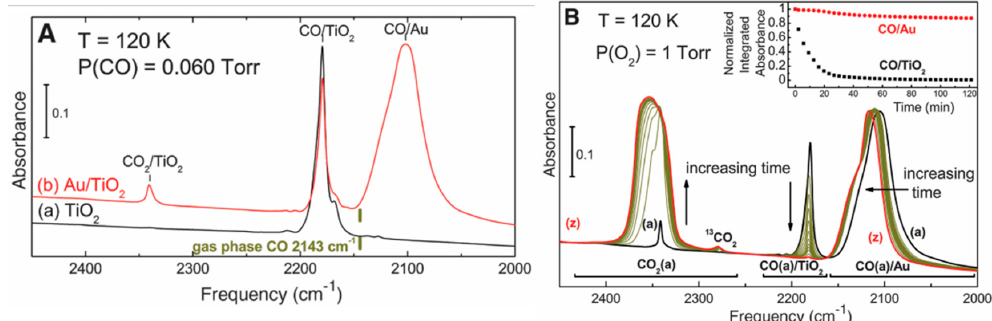
Figure 5. ( A ) IR spectra of saturated CO layer: Spectrum a, TiO 2 ; b, Au/TiO 2 under 0.060 torr of CO pressure at 120 K. ( B ) IR spectral development during the CO oxidation reaction on Au/TiO 2 under 1 torr of O 2 pressure at 120 K: a, before O 2 introduction; z, after 120 min of reaction. The CO/TiO 2